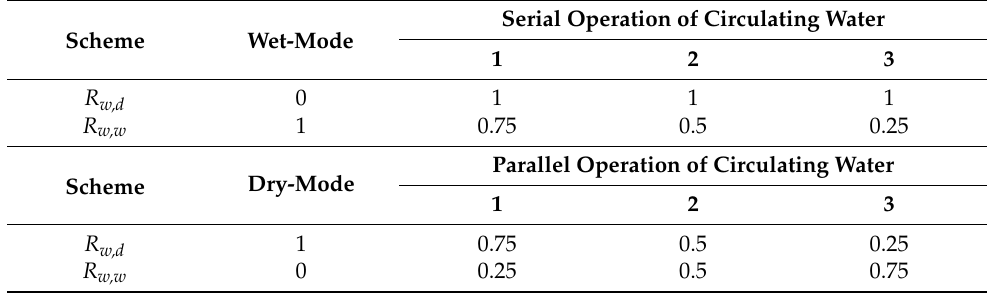
Table 7. Operation strategies of NDHCs.